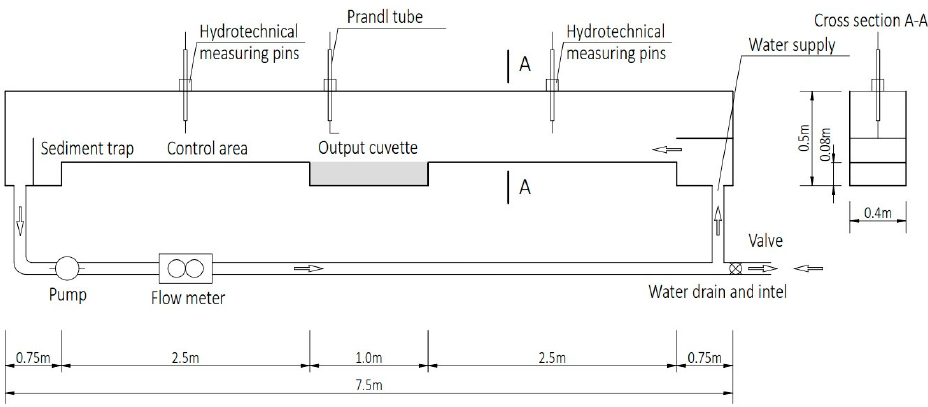
Figure 1. Experimental setup for steady flow measurements Gda ń sk 2021.